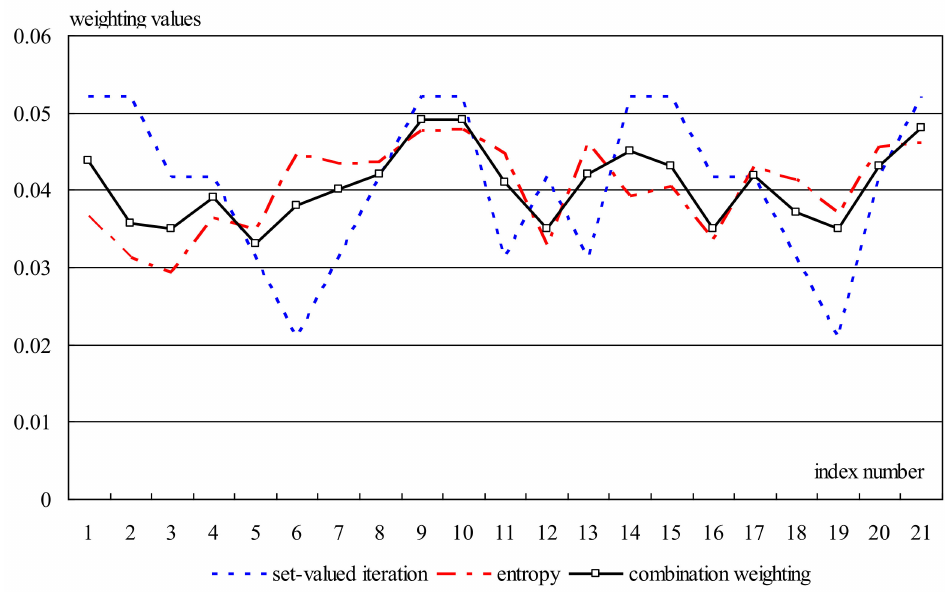
Figure 5. Weighting result comparison with different